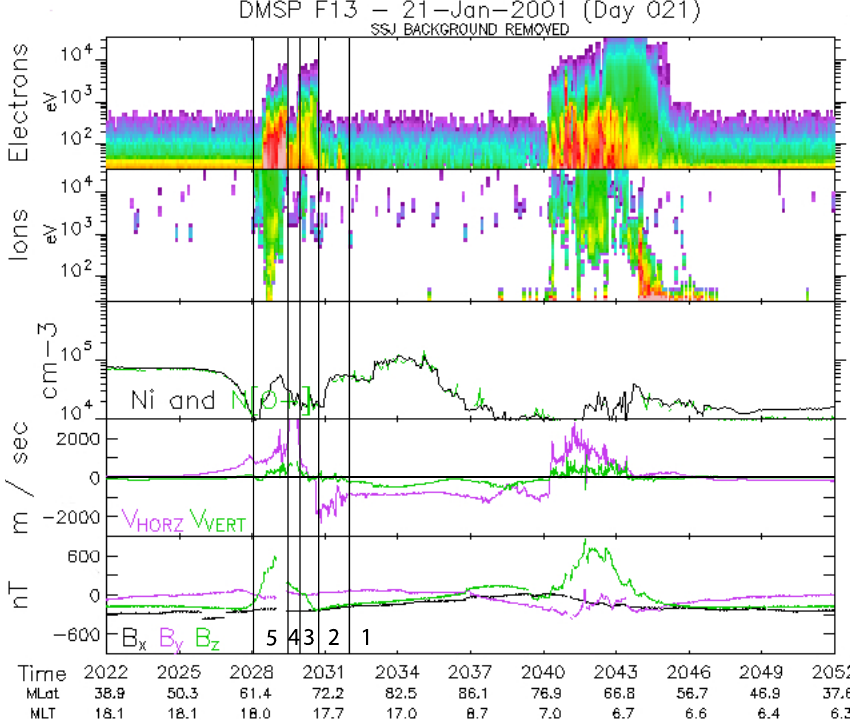
Fig. 20. Northern Hemisphere DMSP F13 data for the interval 20:22–20:52UT. Precipitation/convection/Birkeland current regimes marked in the figure are: (1): P.RAIN (central polar cap); (2): P.RAIN and C1 current and flow channel FC 2; (3): BPS (evening arcs) and C2 current; (4) BPS and R1 current; (5): CPS and R2. Event category: NH-dusk/ B y < 0 (dark).